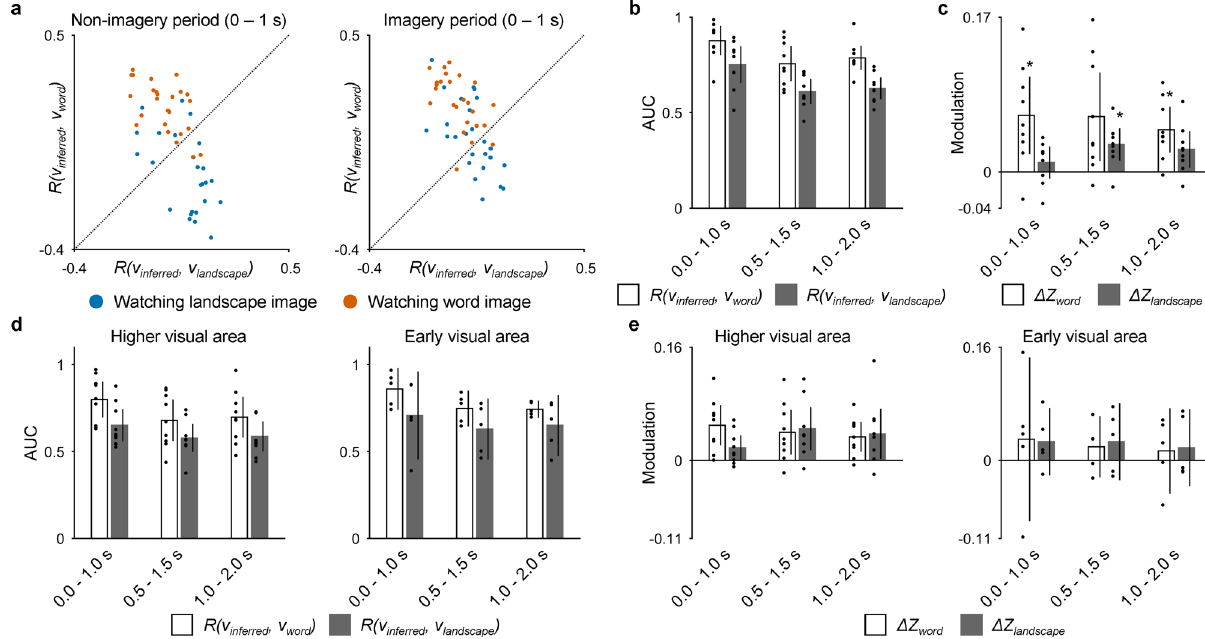
Fig. 7 Modulation of the inferred semantic vectors by mental imagery. a The R ( v inferred , v word ) (vertical axis) and the R ( v inferred , v landscape ) (horizontal axis) for each image were plotted with color-coded (blue, presentation of landscape image; red, presentation of word image) points for E01. b For each 1-s time window, the AUC to identify the category of the presented image (word or landscape) in the nonimagery period solely using R ( v inferred , v word ) or R ( v inferred , v landscape ) is shown with white and black bars, respectively. Individual values are shown with dots. Error bars denote the 95% CIs among subjects ( n = 9). c Δ Z word and Δ Z landscape averaged across the subjects ( n = 9) are shown with white and black bars, respectively, for each 1-s time window. Individual values are shown with dots. Error bars denote 95% CIs among subjects. * P < 0.0083 (Bonferroni-adjusted α -level; 0.05/6), one-sided one-sample t -test. d For each of three 1-s time windows in the nonimagery period, the AUC to identify the category of the presented image based on R ( v inferred , v word ) or R ( v inferred , v landscape ) is shown from using the high- γ features from the higher visual area (left; n = 9) and early visual area (right; n = 5). Individual values are shown with dots. Error bars denote 95% CIs among subjects. e For each 1-s time window and for the high- γ features from higher visual area (left; n = 9) and early visual area (right; n = 5), Δ Z word and Δ Z landscape averaged across the subjects are shown with white and black bars, respectively. Individual values are shown with dots. Error bars denote 95% CIs among